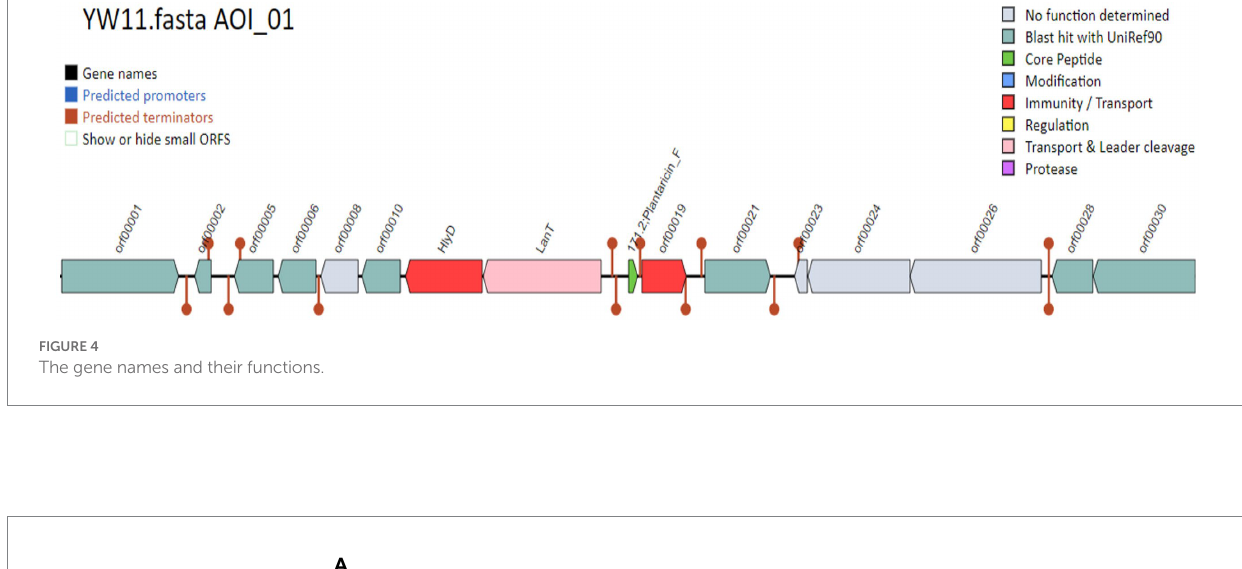
FIGURE 4 The gene names and their functions.